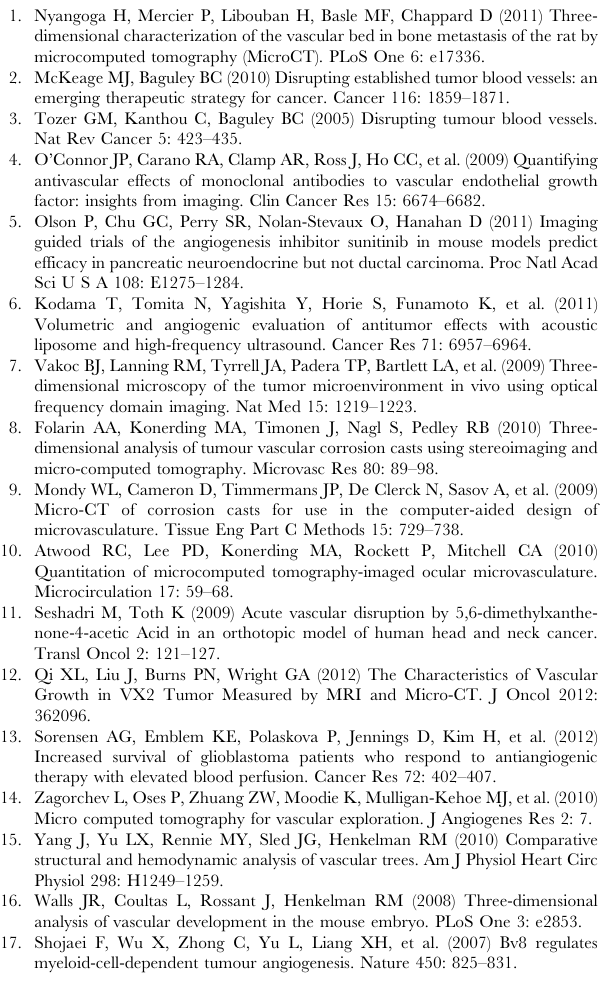
(MOV) Movie S3 3-D maximal spheres model of avascular/ necrotic regions. 3-D renderings of the maximal spheres model of vessel separation. Red indicates a 2 mm, or greater sphere diameter. Images were generated to represent the intact speci- mens, followed by incremental cutplanes through the samples (20 cutplanes per sample) to create frames for a movie for viewing. Two representative tumor samples showing both the heterogeneity and extent of the avascular areas as compared to the kidney control on the